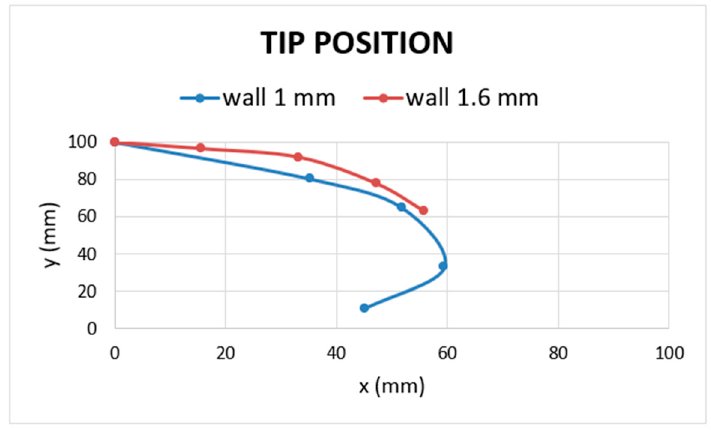
Figure 15. Bending angle vs. input pressure for R-type with wall thickness of 1.6 and 1 mm.